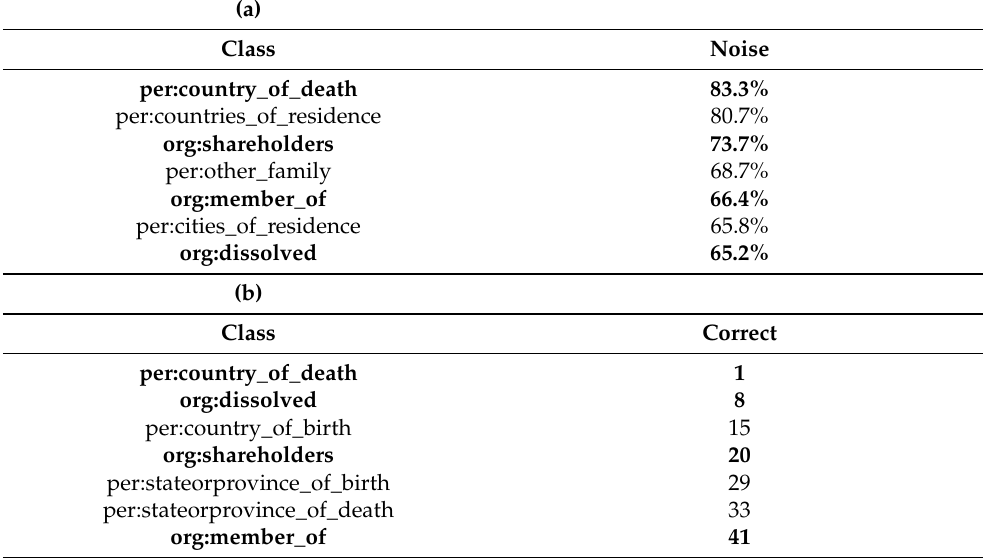
Table 1. Top seven classes in TACRED training dataset ordered by the level of label noise in de- scending order (a) and those ordered by the number of correct instances in ascending order (b). per and org are the abbreviation of person and organization, Noise denotes the the level of label noise for each class which is calculated by # wrong label , and Correct denotes the number of correct labels # instances for each class. Noisy labels, i.e., wrong labels are determined by the refined annotation [9]. Four classes marked in bold font suffer both of noise label and low source availability regime, i.e., MC. MC instances are totally 227 out of 68,124 training instances (0.33%) and the positive class which has most